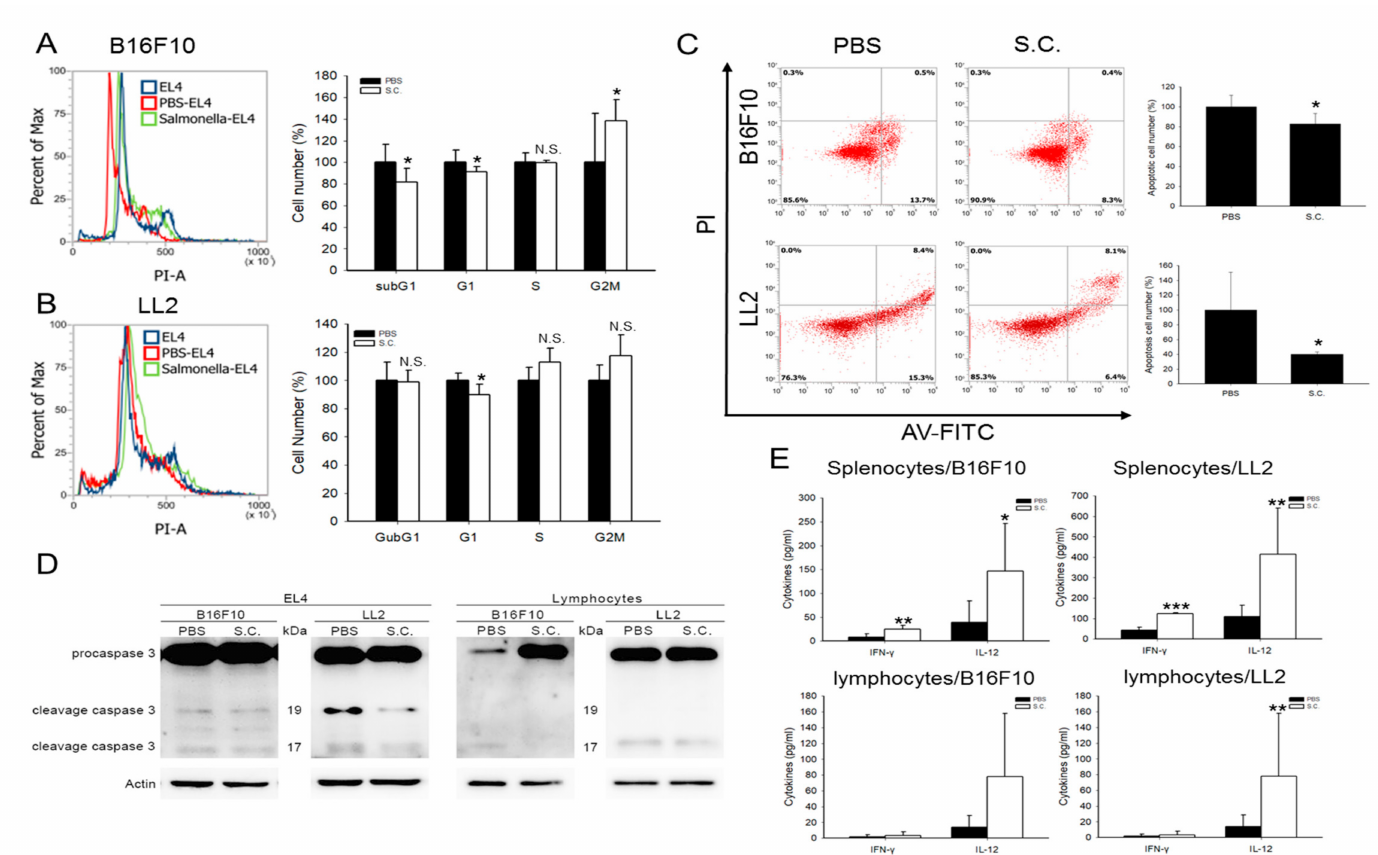
Figure 3. Salmonella (S.C.) a ff ected cell cycle and apoptosis in T cells. Salmonella induced G1 block in the EL4 cell cycle when co-cultured with ( A ) B16F10 and ( B ) LL2 that have been subjected to Salmonella treatment at 100 multiplicity of infection (M.O.I.); cells were stained with propidium iodine, and the cell cycle analysis was performed by flow cytometry. ( C ) EL4 cells were stained with Annexin V and the frequency of apoptotic cells was measured after being co-cultured with Salmonella -infected B16F10 and LL2 cells. ( D ) EL4 cells and lymphocytes were co-cultured with B16F10 and LL2 cells prior to harvesting. Caspase 3 was analyzed by Western blotting. ( E ) Salmonella induced Interferon- γ (IFN- γ ) and interleukin-12 (IL-12) cytokine secretion in splenocytes and lymphocytes which were co-cultured with Salmonella -infected B16F10 and LL2 cells. *, p < 0.05; **, p < 0.01; N.S., not significant. Compared with phosphate bu ff ered saline